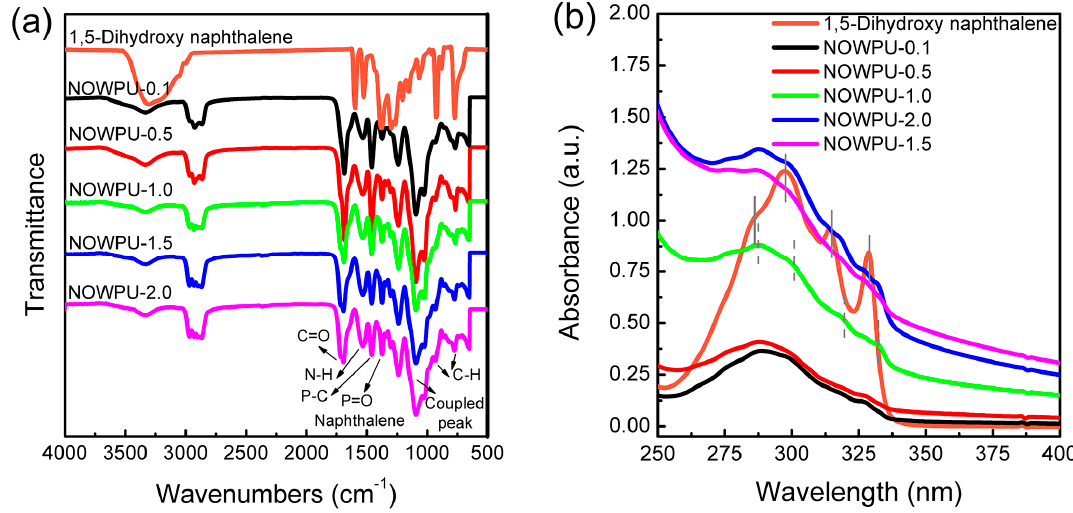
Figure 1. ( a ) Fourier transformed infrared spectroscopy (FTIR) and ( b ) UV-vis spectrum of NOWPUs.